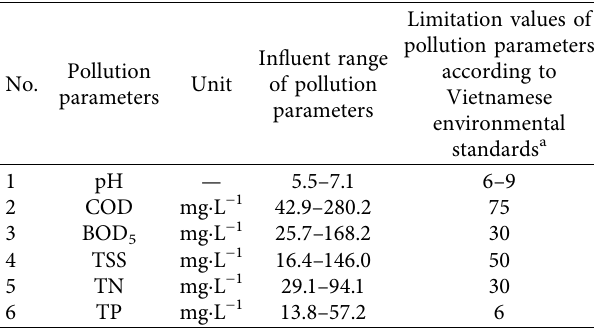
Table 1: The influent range of pollution parameters and their limitation values according to Vietnamese environmental